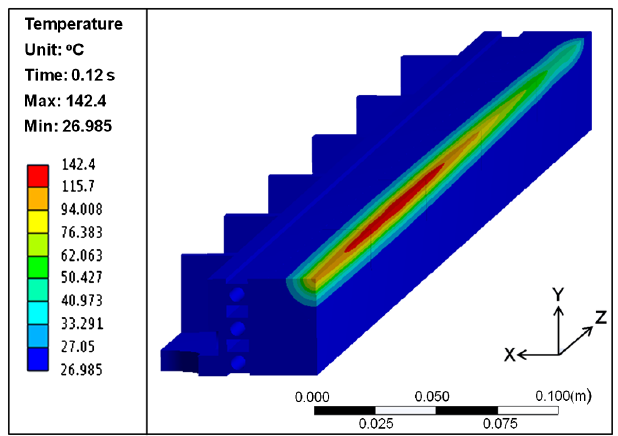
FIG. 18. Temperature distribution for the ‘ 3.5 TeV, − 1 mrad ’ case at 120 ms after the beam impact.